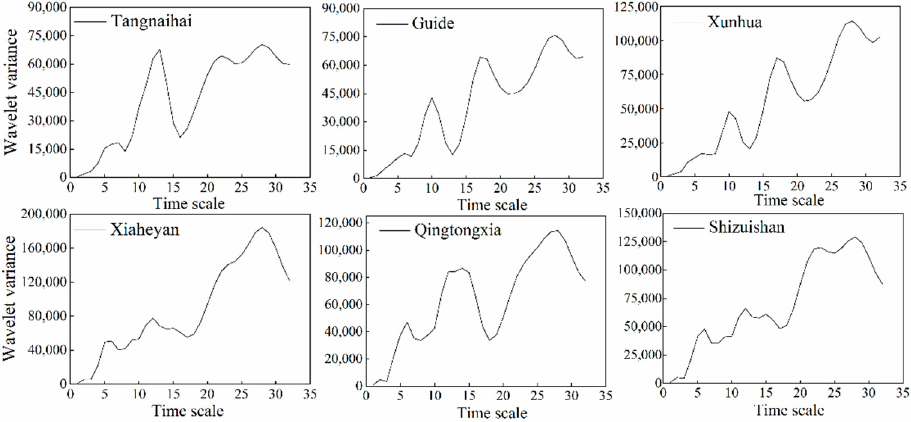
Figure 6. Wavelet variance diagram of the baseflow time series at the six hydrological stations.